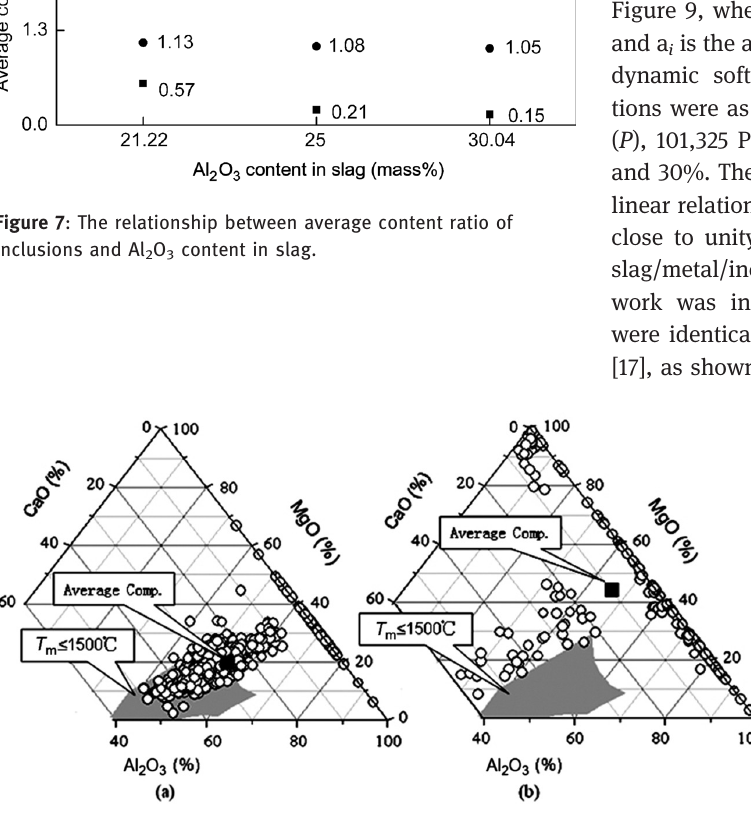
Figure 8 : Effect of slag on composition distribution of the inclusions [9]. (a) Slag A; (b) slag B.